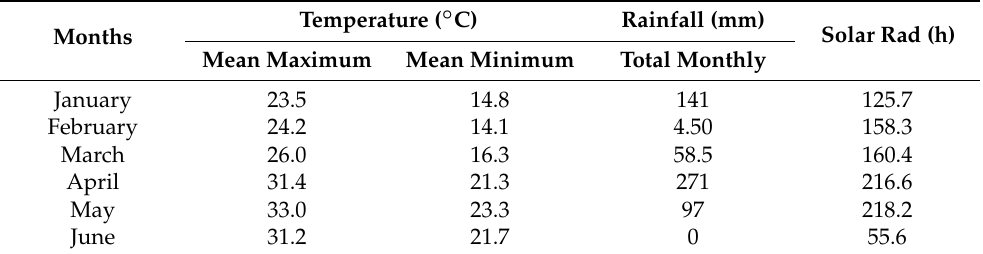
Table 1. Temperature, rainfall and sunshine hours during the crop cycle.